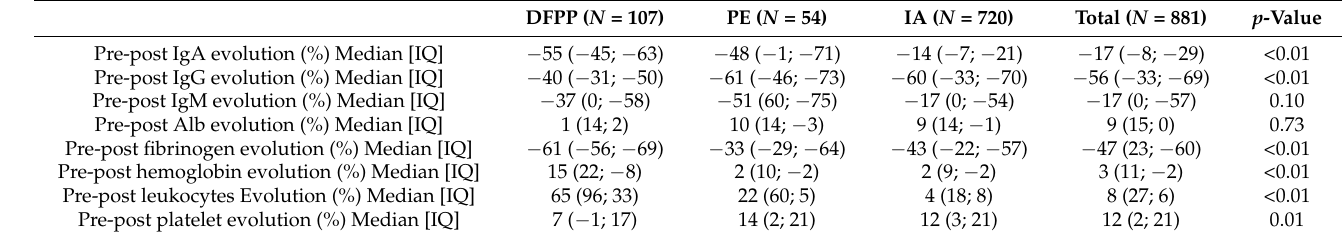
Table 5. Biological parameters according to apheresis